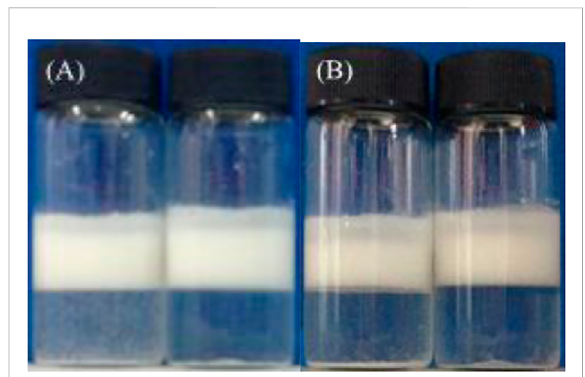
FIGURE 10 Appearance of the water-in-toluene-in-water multiple emulsions, taken (A) 1 day and (B) 1 week after preparation by magnetic stirring (left) and homogenization (right). The inner W/O emulsion is stabilized by 1.0 wt% CaCO 3 nanoparticles in combination with 3 × 10 − 3 mol/L SDS, and the outer water phase contains 1.0 wt% CaCO 3 nanoparticles and 3 × 10 − 4 mol/L SDS. Thevolumeratioininnerwater-in-tolueneemulsionis1:1,andthe volume ratio of inner water-in-toluene emulsion to outer water phase is